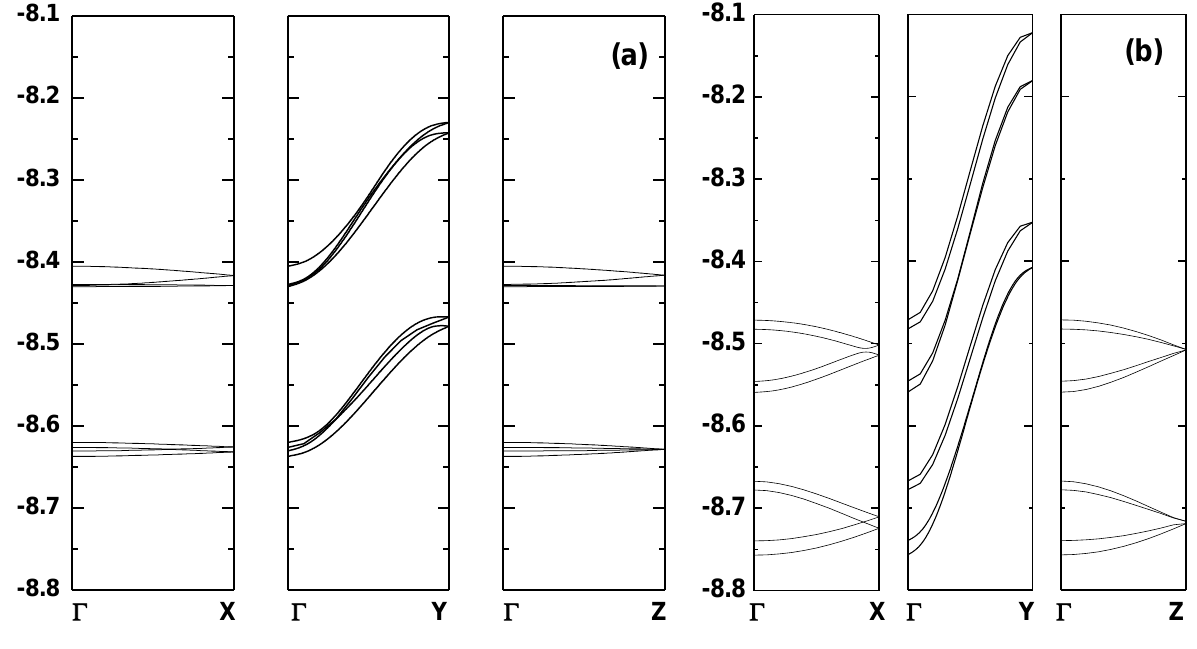
Figure 10. ( a ) Calculated band structures for radical 11 based on X-ray structure at 100 K; ( b ) represents band structure for radical 7 based on structure at 223 K. Reprinted with permission from [48] Copyright 2004, American Chemical